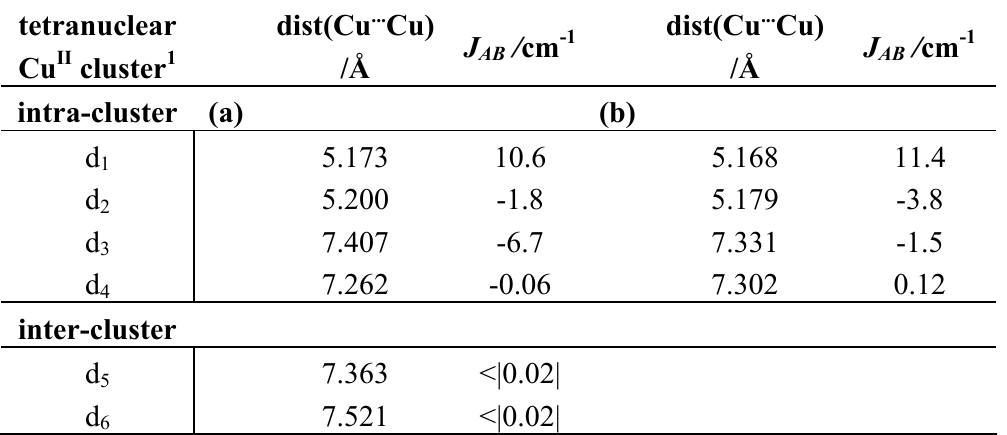
Table 1. Cu ... Cu distances for spin-containing metal centre pairs d1-d6 for